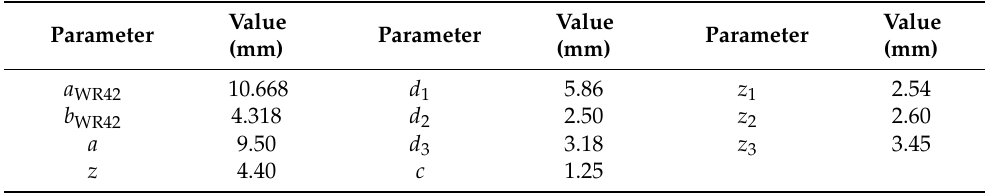
Figure 1. Isometric CAD view of the proposed very compact two-probe waveguide OMT with port numbering ( left ) and associated design parameters in top CAD ( top right ) and side CAD views ( bottom right ). Table 1. Design parameters of the very compact two-probe waveguide OMT in the K-band with WR42